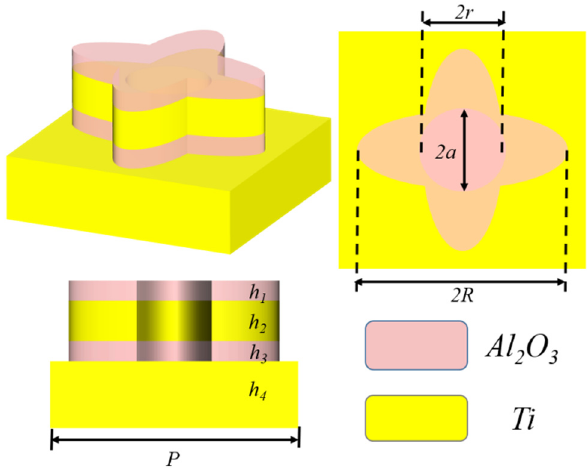
Figure 1. Diagram of titanium and Al 2 O 3 elliptical disk cross-structure of broadband absorber.